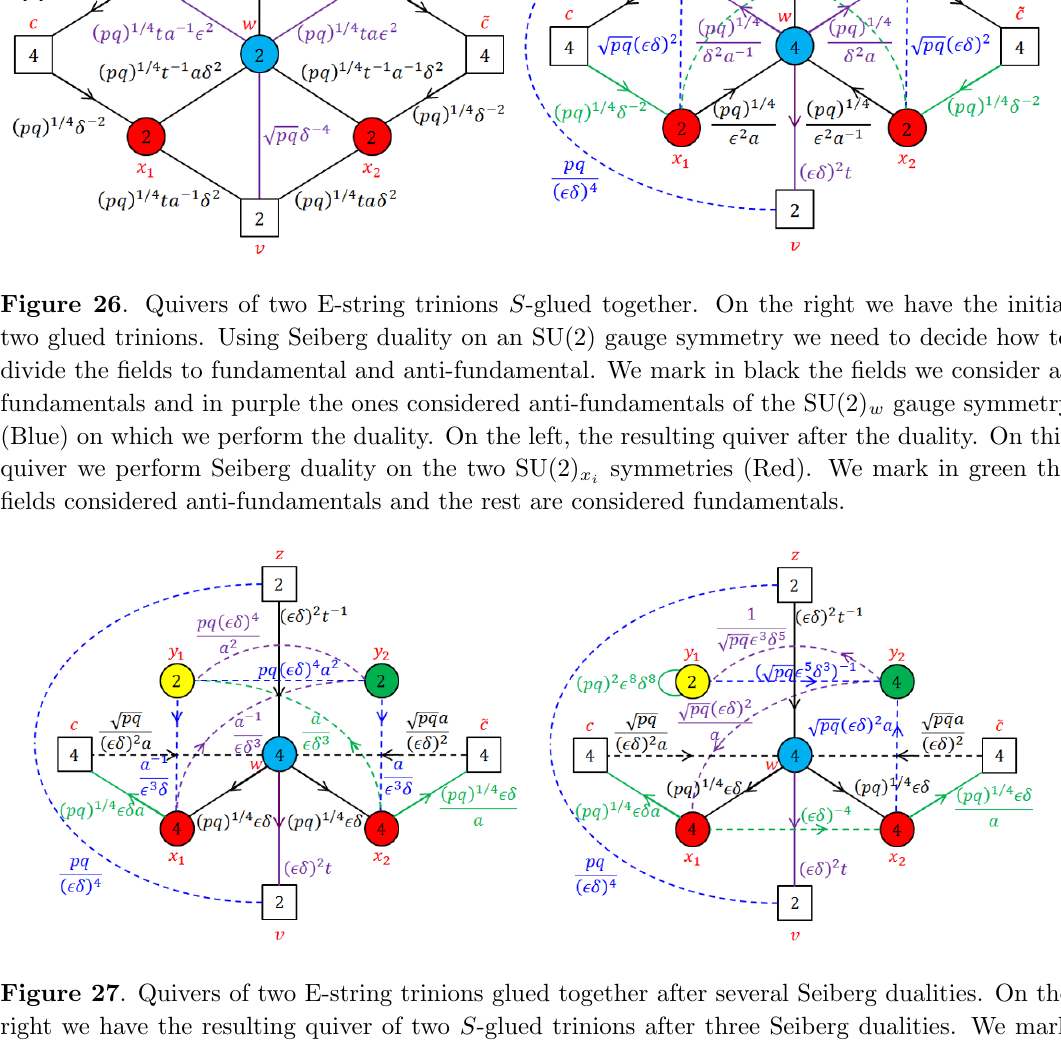
gauge symmetry 2